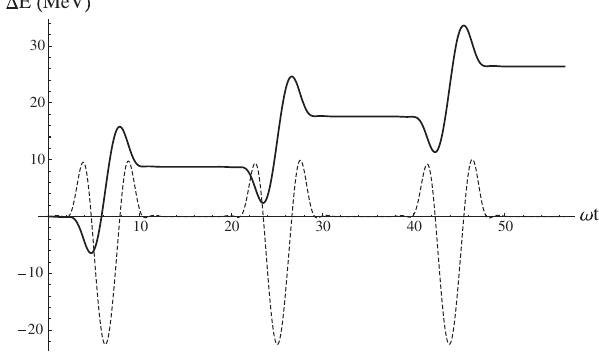
FIG. 3. Black line: net energy gain Δ E in MeV versus ω t for a 100 MeVelectron injected into the focus of three 1 TW Gaussian ~ E beams ( λ ¼ 1 μ m, w 0 ¼ λ = 3 ). The accelerating field x experi- enced by the particle at the time ω t is also shown (dashed line). located at a distance 3 λ in x ( Δ kx ¼ 6 π ). The accelerating ~ E field x experienced along its trajectory is also shown. Fig. 4. The continuous and short-dashed lines indicate the position and β z of the particle along kz ( kz ¼ 2 π corre- sponds to z ¼ λ ) as a function of ω t . The long-dashed and ~ B ~ E dotted lines show the values of the fields y and z (divided by 30 to ease the reading of the plot) experienced along the trajectory. For an ultrarelativistic particle (100 MeV elec- tron in Fig. 4) starting at kx 0 ¼ − 2 π , the focus is reached at ω t ¼ 2 π . Far from the focus, both E B z and y are positive and deflect the particle toward negative values of z . Near